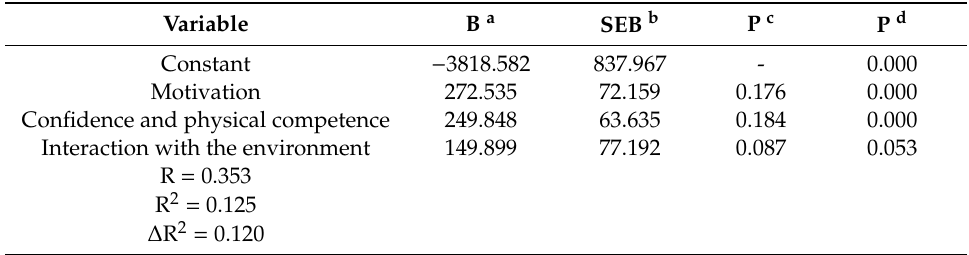
Table 2. Results of multiple linear regression analysis predicting PA level using perceived PL and its dimensions ( n =